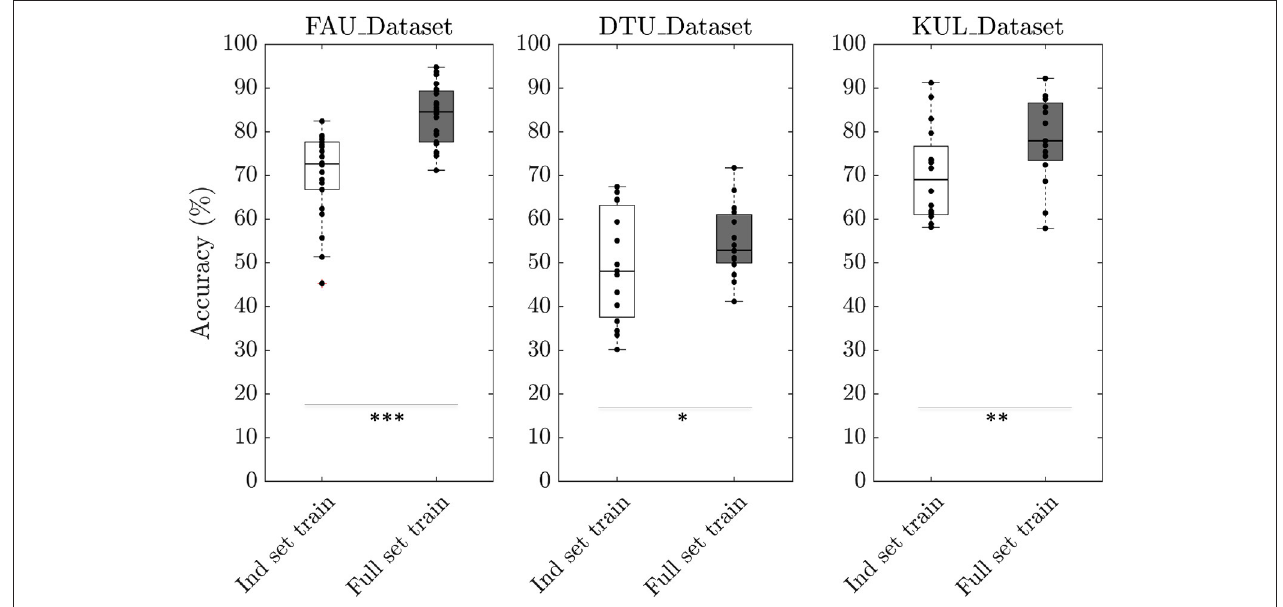
FIGURE 2 | Boxplot depicting the decoding accuracies obtained using two different training scenarios. In the first scenario ( Ind set train ), individual dataset accuracies were obtained by using training samples only from that particular dataset. For example, to calculate the test accuracy of FAU_Dataset, training samples were taken only from FAU_Dataset. In the second scenario ( Full set train ), individual dataset accuracies were obtained using training samples from all the three datasets combined. As a result, there are more training samples in the second scenario compared to the first ( ∗ p < 0.05; ∗∗ p < 0.01; ∗∗∗ p < 0.001 based on paired Wilcoxon signed-rank test).